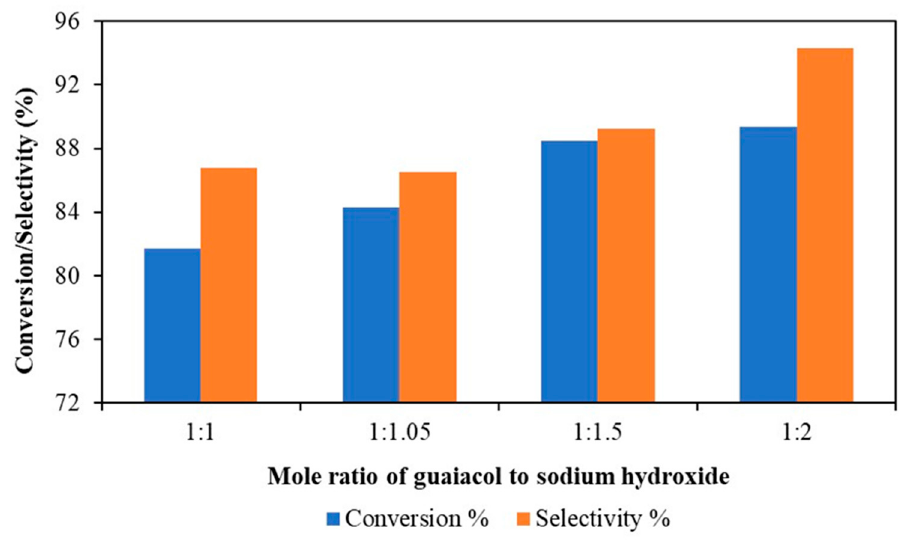
Figure 6. Effect of the mole ratio of guaiacol to sodium hydroxide. Epichlorohydrin 0.1 mol, n-decane 0.03 mol, toluene 150 cm 3 , sodium chloride 0.6 mol, tetra-n-butylammonium bromide 0.14 mol, and water 150 cm 3 . Temperature 40 °C, speed of agitation 60 rpm for all three phases, and reaction time 6 h.